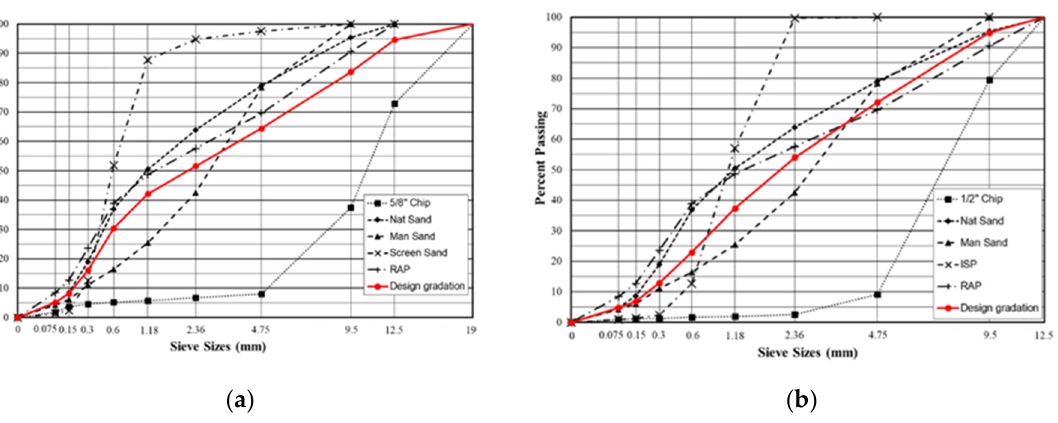
Figure 1. The specified asphalt mixes’ aggregate gradation. ( a ) The gradation design in leveling course; ( b ) the gradation design in surface course.